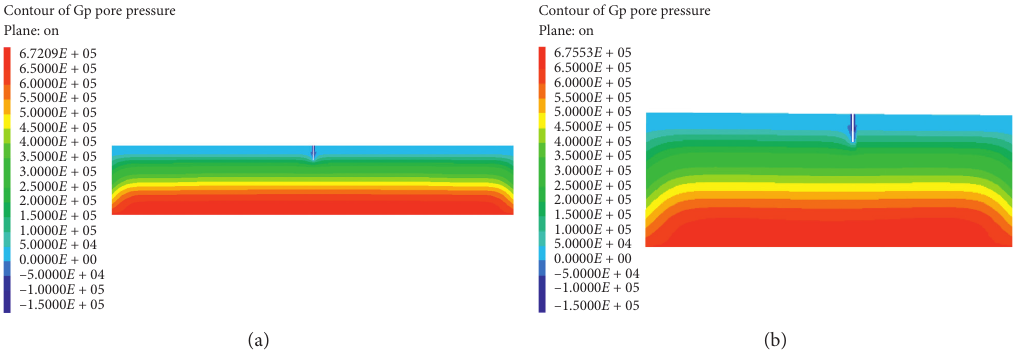
Figure 17: Single well pore water pressure nephogram after the first drawdown (unit: Pa). (a) Cross section of the well midpoint. (b) Longitudinal section of the well midpoint.